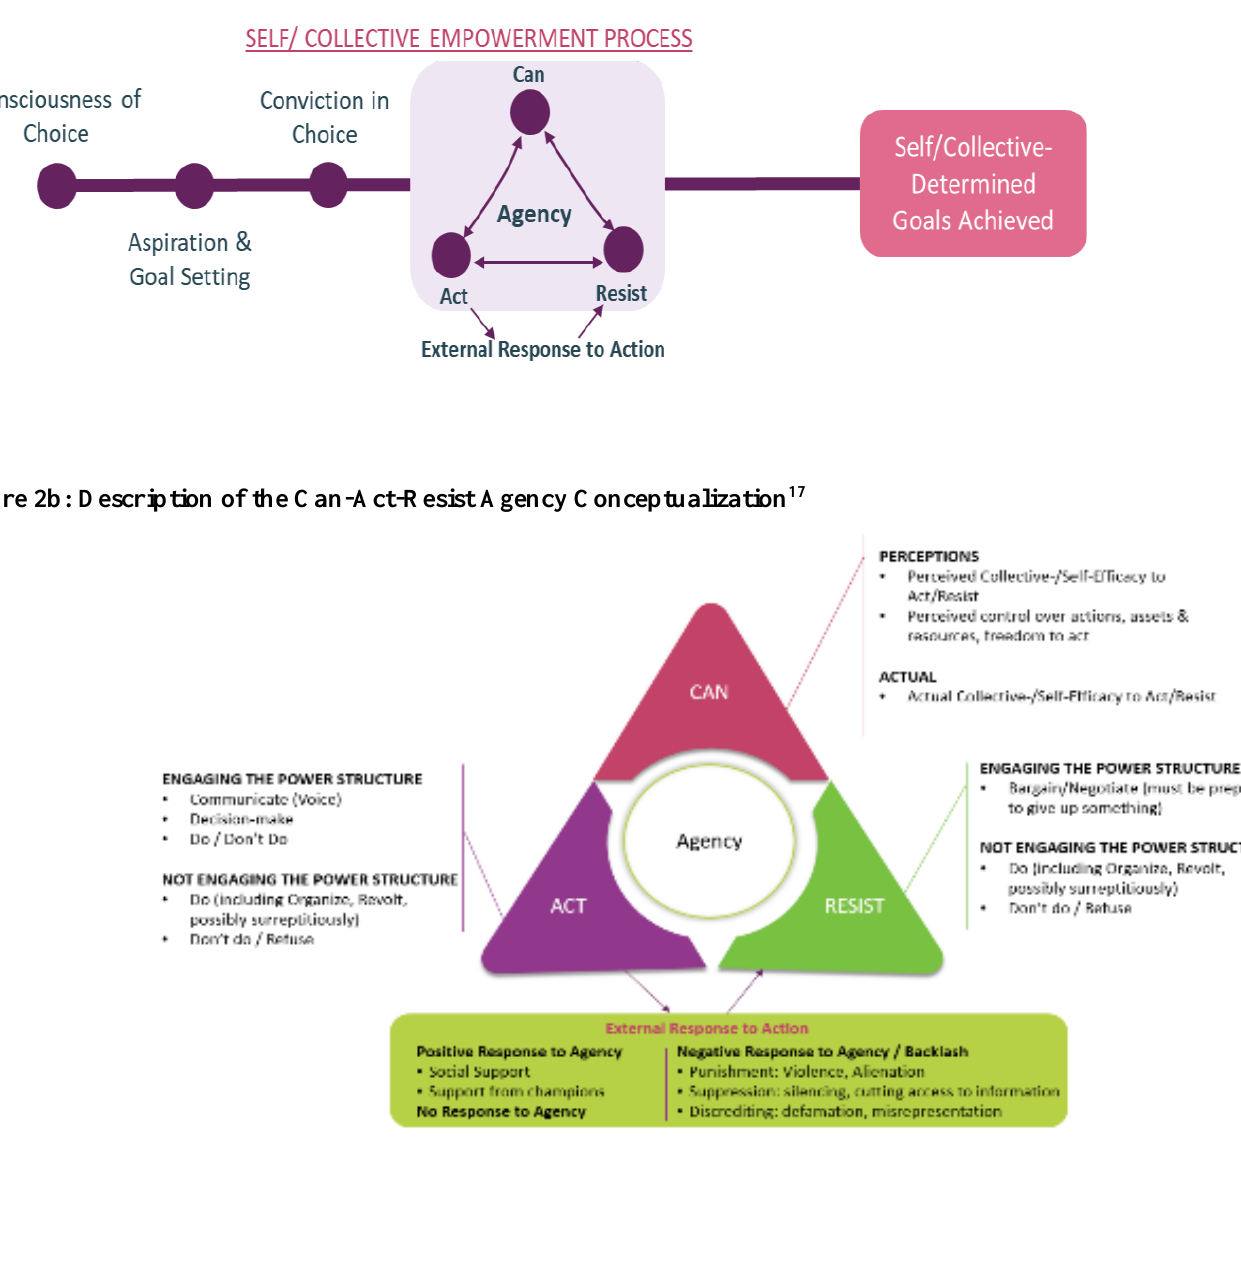
Figure 2a: Conceptualization of the Empowerment Process and locating Agency 17